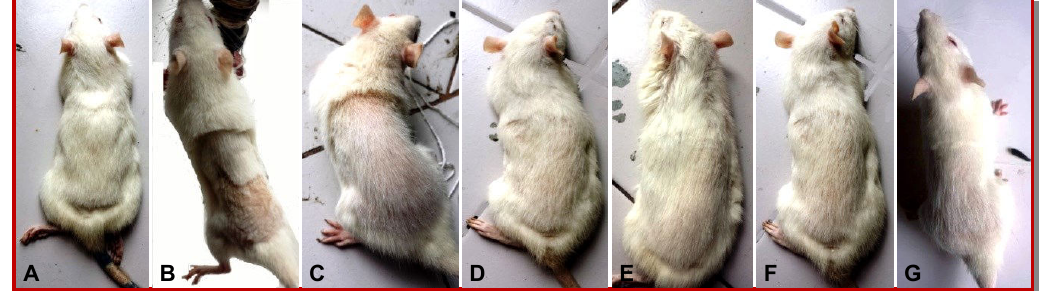
Figure 5: Macroscopic changes in different groups on day 35 of experiment; A: normal control, B: disease control, C: standard, D: 5% N. sativa decoction, E: 10% N. sativa decoction, F: 15% N. sativa decoction, G: N. sativa